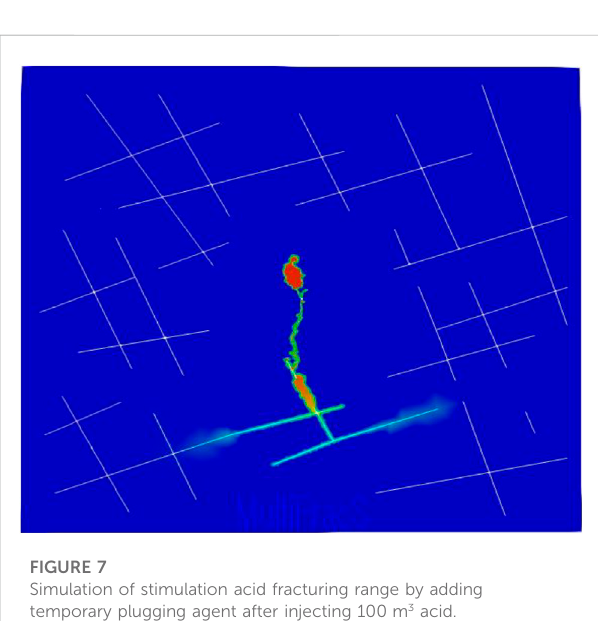
FIGURE 6 Simulation of acid fracturing stimulation range when temporary pluggingagentisaddedimmediatelyafteracidfracturingfracturepass through the natural fracture.